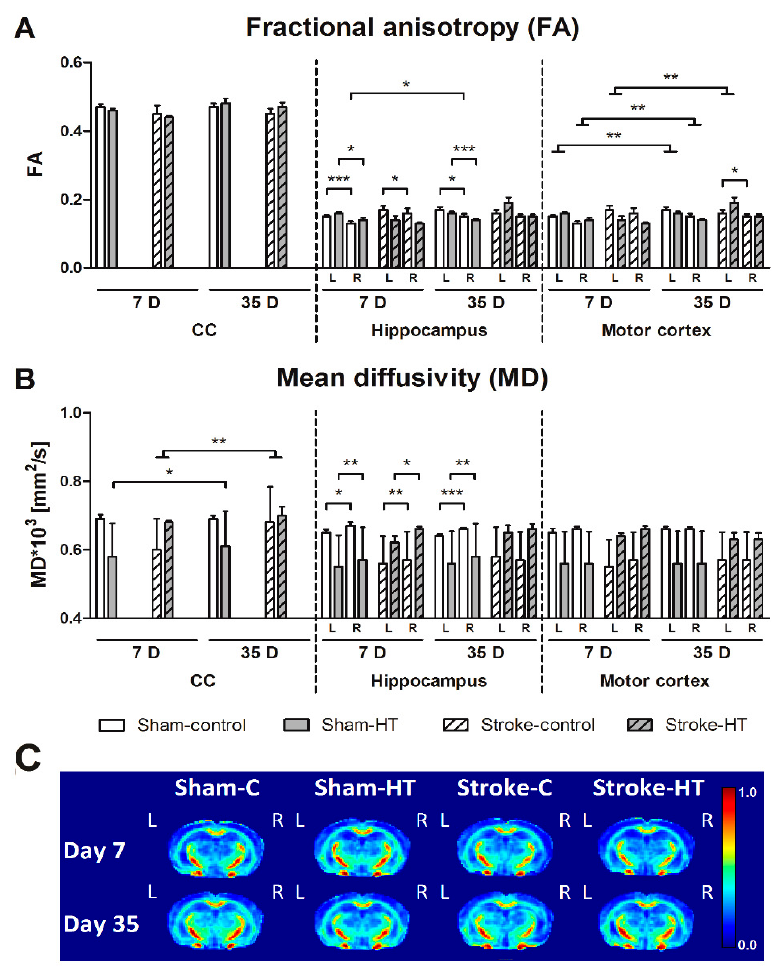
Figure 11. White matter (WM) and grey matter (GM) integrity as measured by quantitatively assessed diffusion tensor-derived indices at 7 + 35 days poststroke in mice fed HT or Control diet. Fractional anisotropy (FA) ( A ) and mean diffusivity (MD) ( B ) were measured for ROI drawn in white (Corpus Callosum, CC) and grey matter (Hippocampus, motor cortex) regions. ( A ) In sham-control (7D, p < 0.001; 35D, p < 0.011) and sham-HT mice (7D, p < 0.020; 35D, p < 0.001), FA in the right hippocampus was lower than in the left hippocampus at seven days and 35 days after surgery. Only in stroke-control mice at seven days post-stroke FA was decreased in the right hippocampus compared to its contralateral counterpart ( p < 0.022). FA in the right hippocampus also increased between seven days and 35 days after surgery in sham-control mice ( p < 0.035). A lowered FA in the right the motor cortex compared to left motor cortex was only found at 35 days in stroke-control ( p < 0.033) mice. In the left motor cortex, stroke mice had an FA increase in the hemisphere at 35 days post-stroke compared to seven days post-stroke ( p < 0.006). Sham animals showed a decrease of FA in both the left ( p < 0.003) and right ( p < 0.004) motor cortex over time (35 days vs. seven days). ( B ) MD was higher in the right hippocampus than in the left hippocampus at seven days post-surgery in all groups (Sham-control: p < 0.013; Sham-HT: p < 0.004; Stroke-control: p < 0.006; Stroke-HT: p < 0.050), while at 35 days, it was higher only in sham mice (Sham-control: p < 0.001; Sham-HT: p < 0.002). Only in stroke-control mice at seven days post-surgery, a higher MD in the right motor cortex than the left motor cortex was detected ( p < 0.075). Sham-HT mice had a heightened MD of the corpus callosum at 35 days compared to seven days post-surgery ( p < 0.033). All stroke mice also showed a higher MD in the corpus callosum 35 days compared to seven days post-surgery ( p < 0.008). ( C ) Representative high-resolution set of FA images for each dietary group at seven and 35 days poststroke. * p < 0.05, ** p < 0.01, *** p < 0.001.